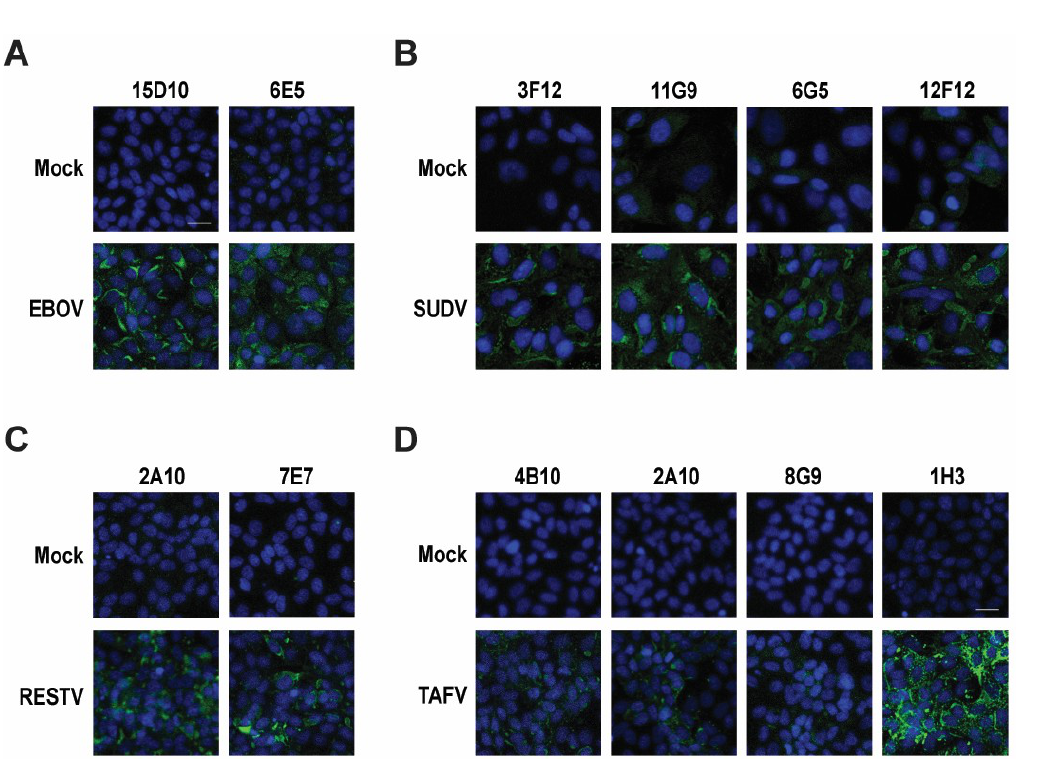
Figure 3 . Anti-NP filovirus mAbs detected the native filovirus NP in confocal microscopy (CM). In CM, the cells were infected with a multiplicity of infection (MOI) of 3, fixed and permeabilized at 48 h post-infection (hpi), and stained with different anti-filovirus NP mAbs; the nuclei were stained with